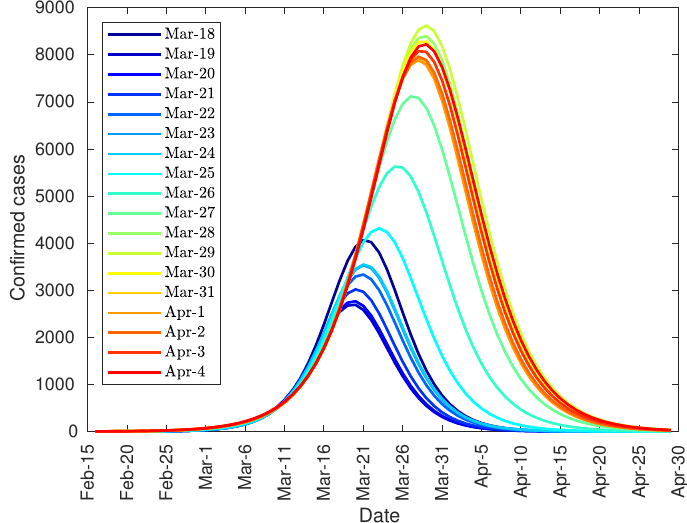
Figure 10. Evolution of the peak of diagnosed COVID-19 patients in Spain.